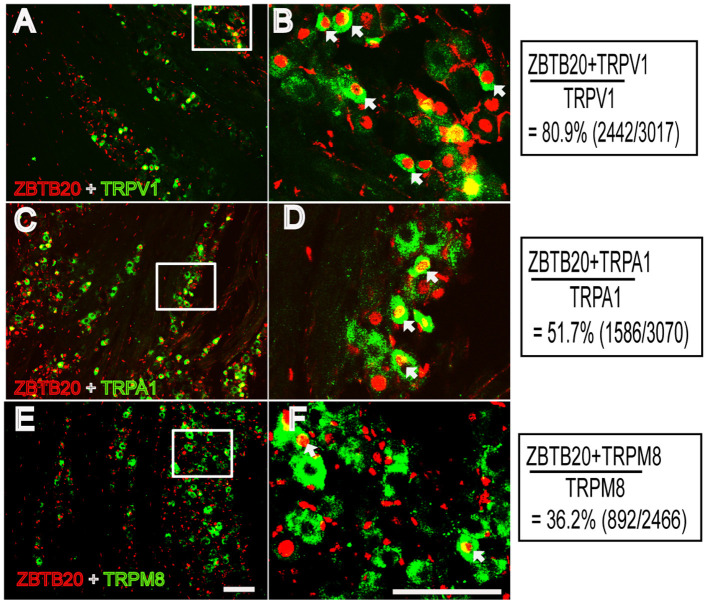
Colocalization of ZBTB20 with TRPV1, TPRA1, and TRPM8 in the trigeminal ganglia (A,B) Colocalization of ZBTB20 with TRPV1. (C,D) Colocalization of ZBTB20 with TRPA1. (E,F) Colocalization of ZBTB20 with TRPM8. Figures B,D,F are high magnifications of the boxes in Figures A,C,E. The arrowhead indicates the colocalization of ZBTB20 with TRPV1, TRPA1, and TRPM8 in Figures B,D,F. N = 3; bar =50 μm.